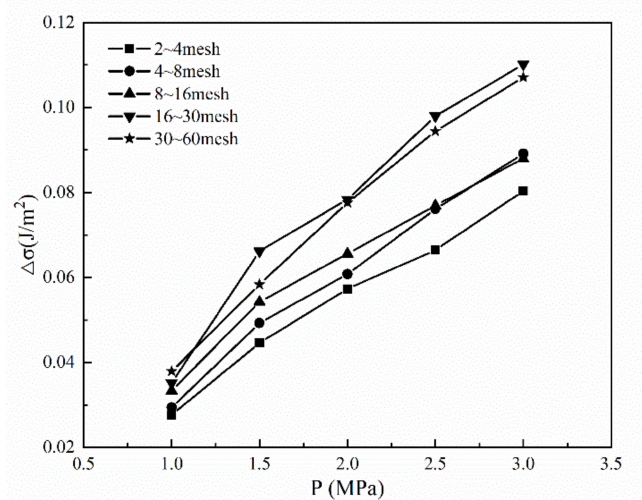
Figure 6. Reduction in surface free energy with